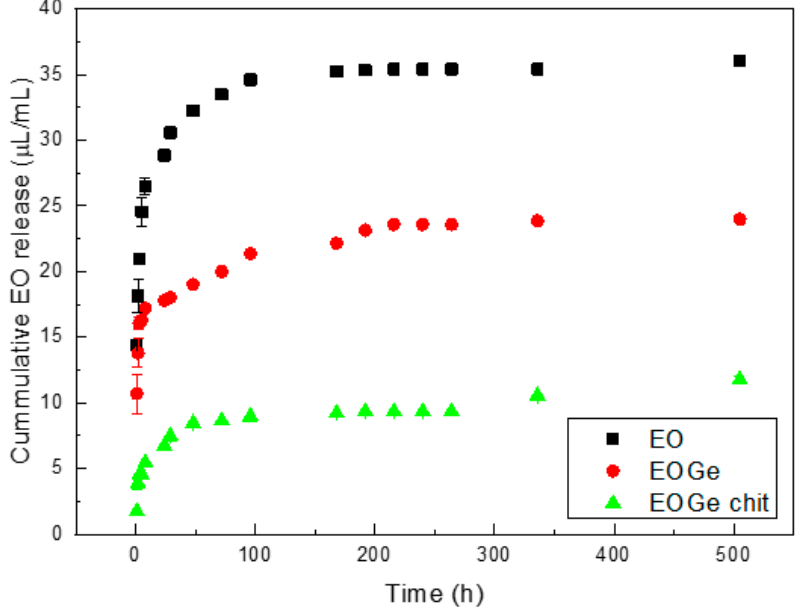
Figure 6. Release of EO (µL/mL) from MBG EO, MBG EOGe and MBG EOGe chit particles in PBS.